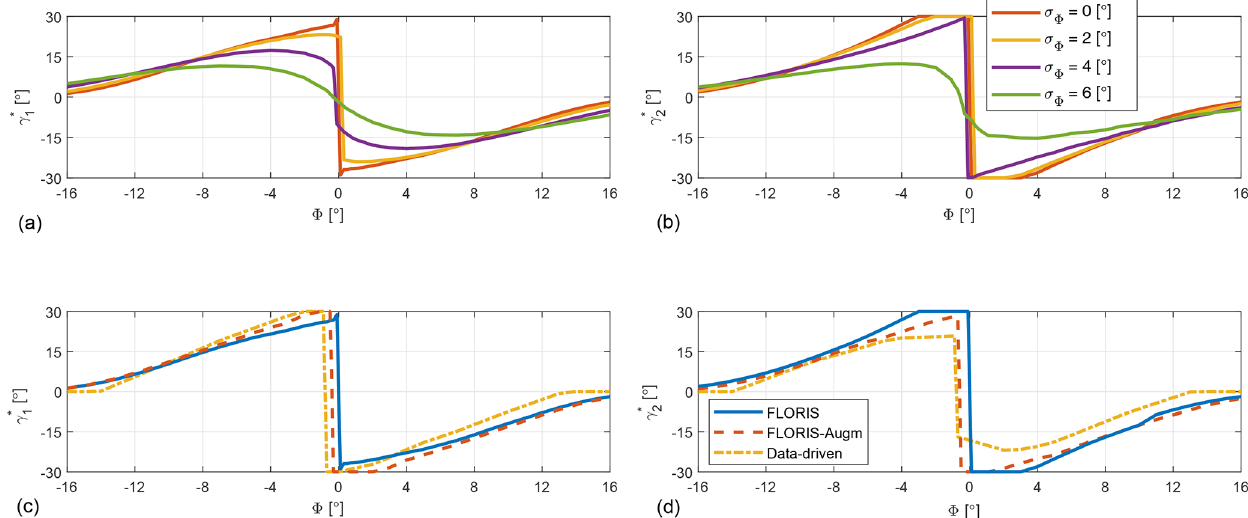
Figure 9. LUTs of optimal misalignment angles γ 1 and γ 2 vs. wind direction (cid:56) . (a, b) FLORIS LUTs for different uncertainty levels. γ ∗ for WT1 (a) , γ ∗ for WT2 (b) . (c, d) LUTs for different models and σ (cid:56) = 0 ◦ . γ ∗ 2